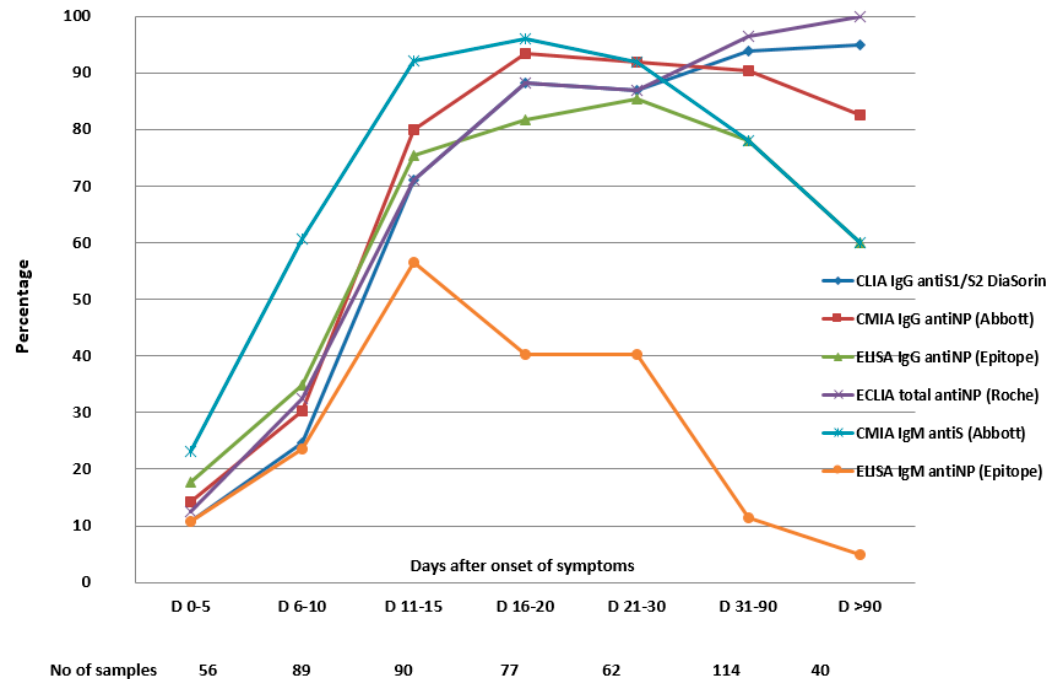
Figure 1. Dynamic trends of seropositivity rate according to the evaluated assays. Each time point from the x-axis represents the cumulated seropositivity rate at that specific time point.